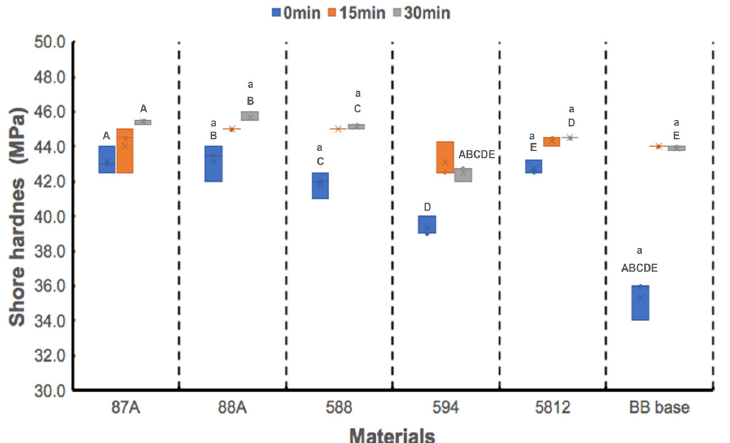
Figure 6. Shore hardness values of 5 urethane acrylate UA-based photopolymer resins and a BB base. Same capital letter indicates static difference between materials for each UV-exposure period; same small letter indicates static difference between UV-exposure periods for each material.